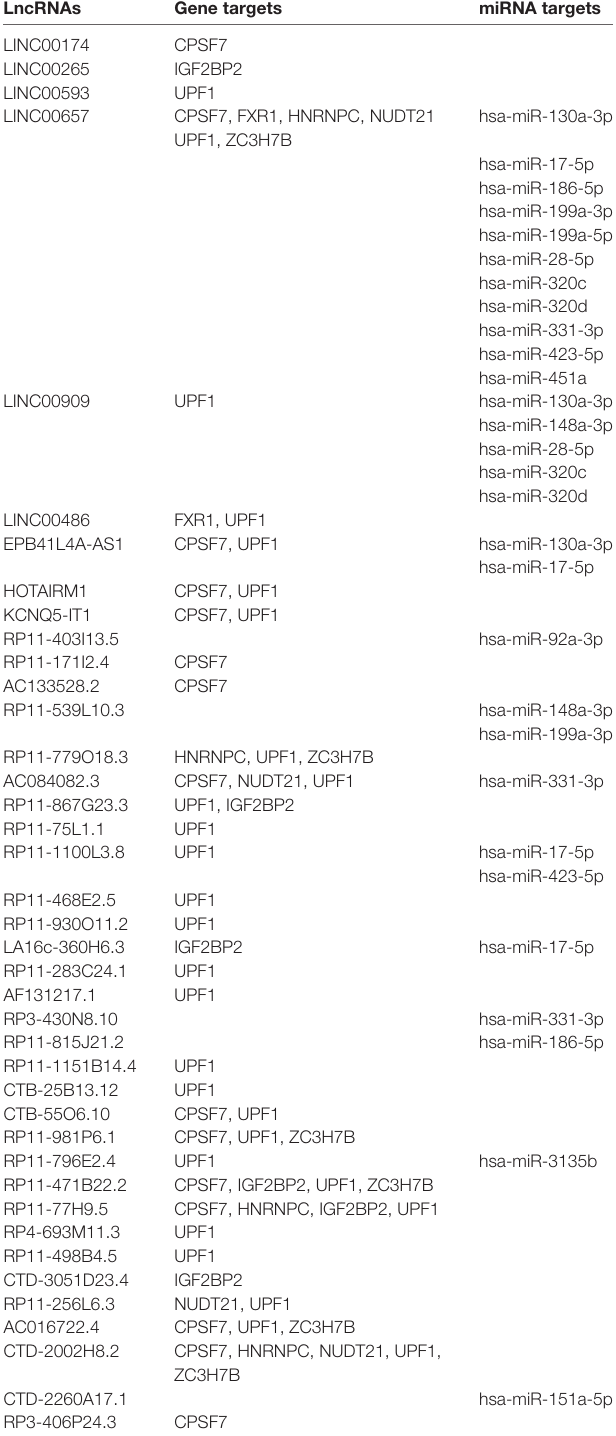
TaBle 2 | Long non-coding RNAs (LncRNAs) and their targets modulated in psoriatic